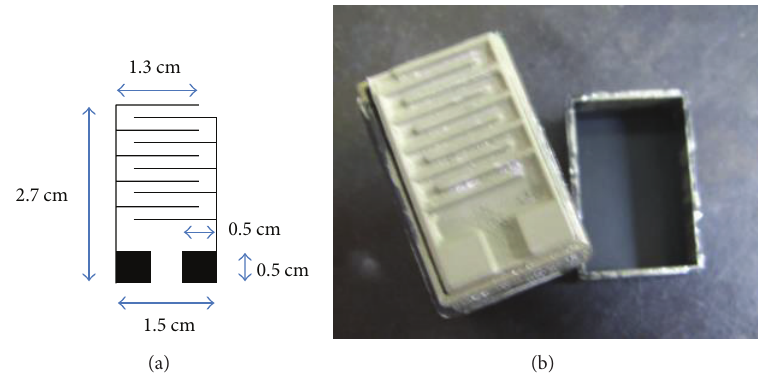
Figure 1: Schematic diagram of the dimensions of interdigitated electrode and the actual stamp with IDE